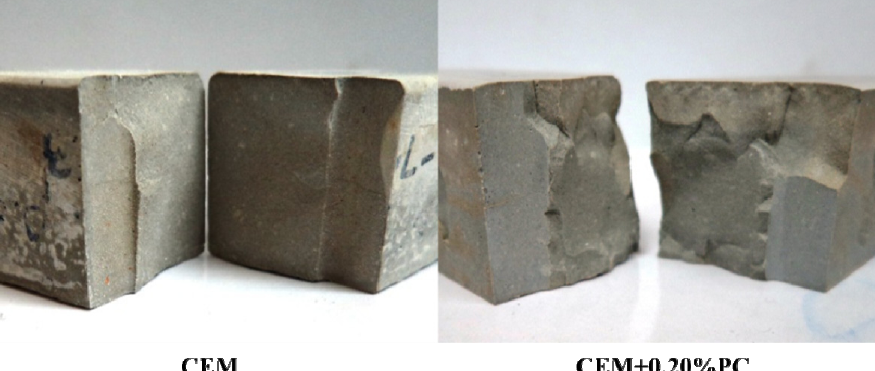
Figure 9: Typical fracture surfaces of the cement composites tested in